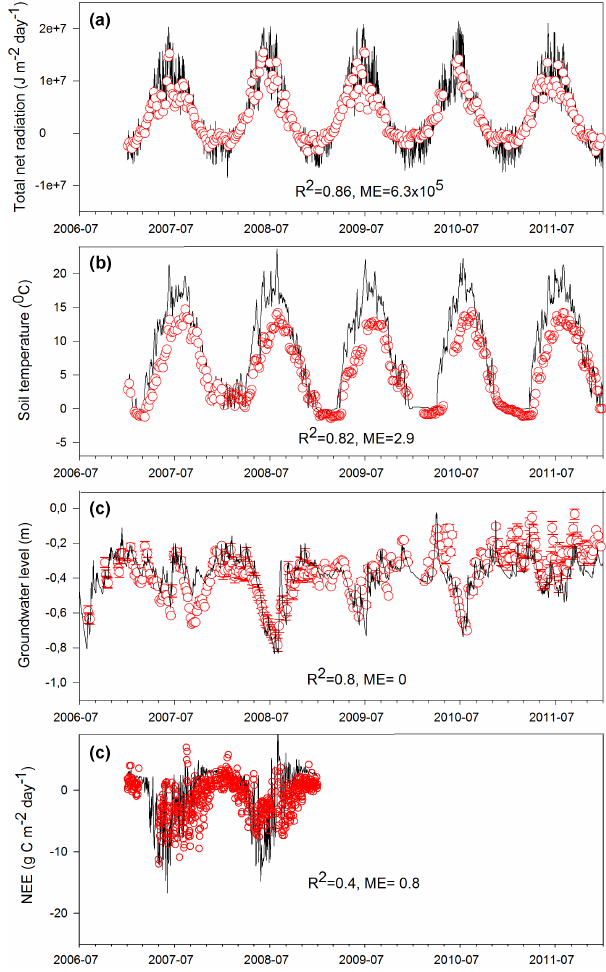
Figure 4. (a) Simulated (black line) and measured (red hollow cir- cle) total net radiation; (b) soil surface temperature (0–5cm depth; c ) GWL; (d) NEE. Measured data used to create these plots are 5- day averages, except for NEE where daily averages have been